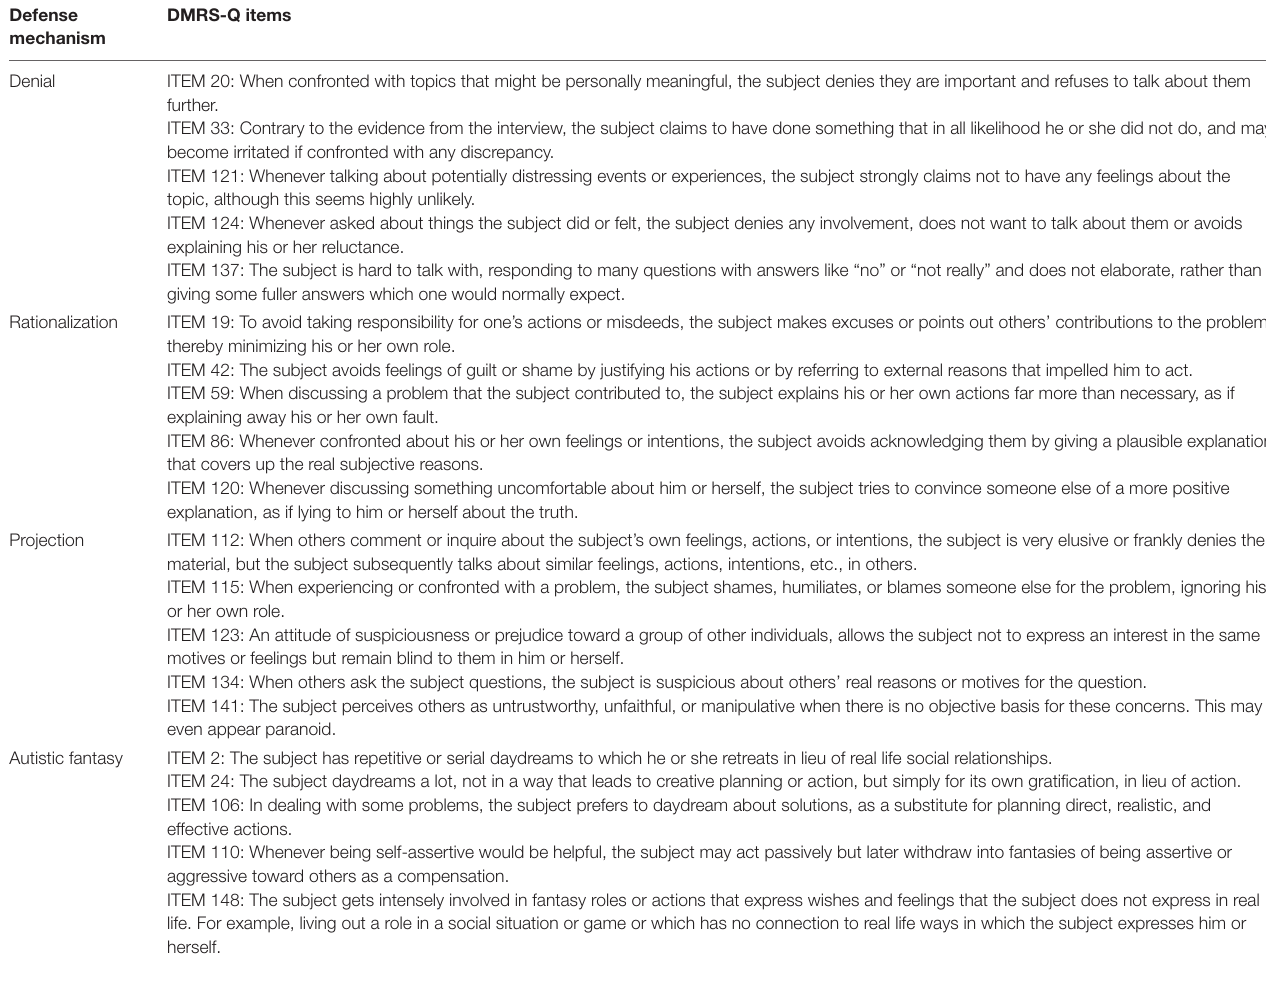
TABLE 6 | Disavowal defense level: Definition, function and DMRS-Q items of defenses denial, rationalization, projection, and autistic fantasy. Defense